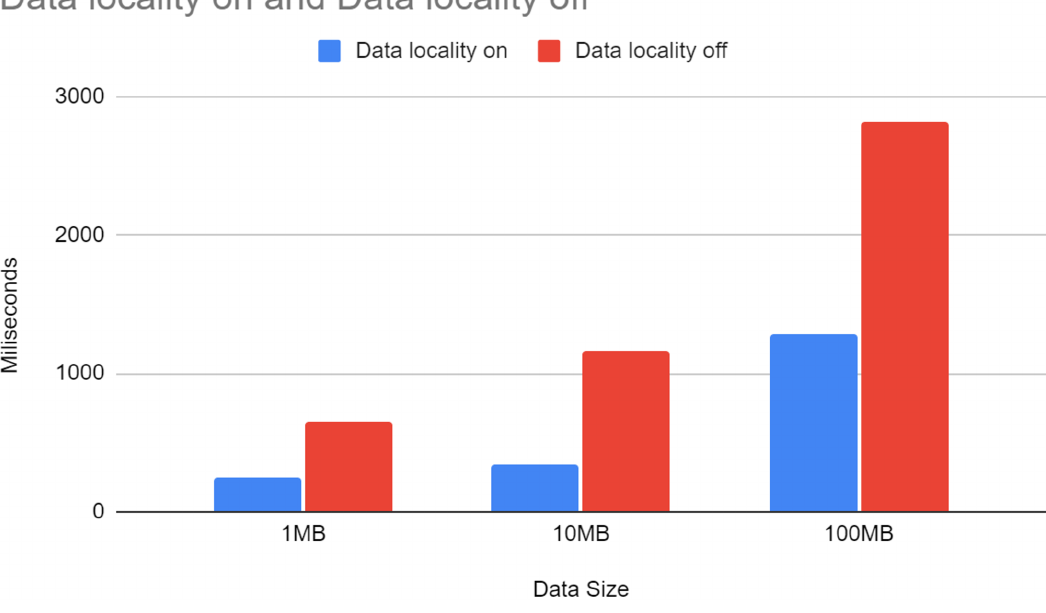
Figure 9. Average time spent on transferring data with and without data